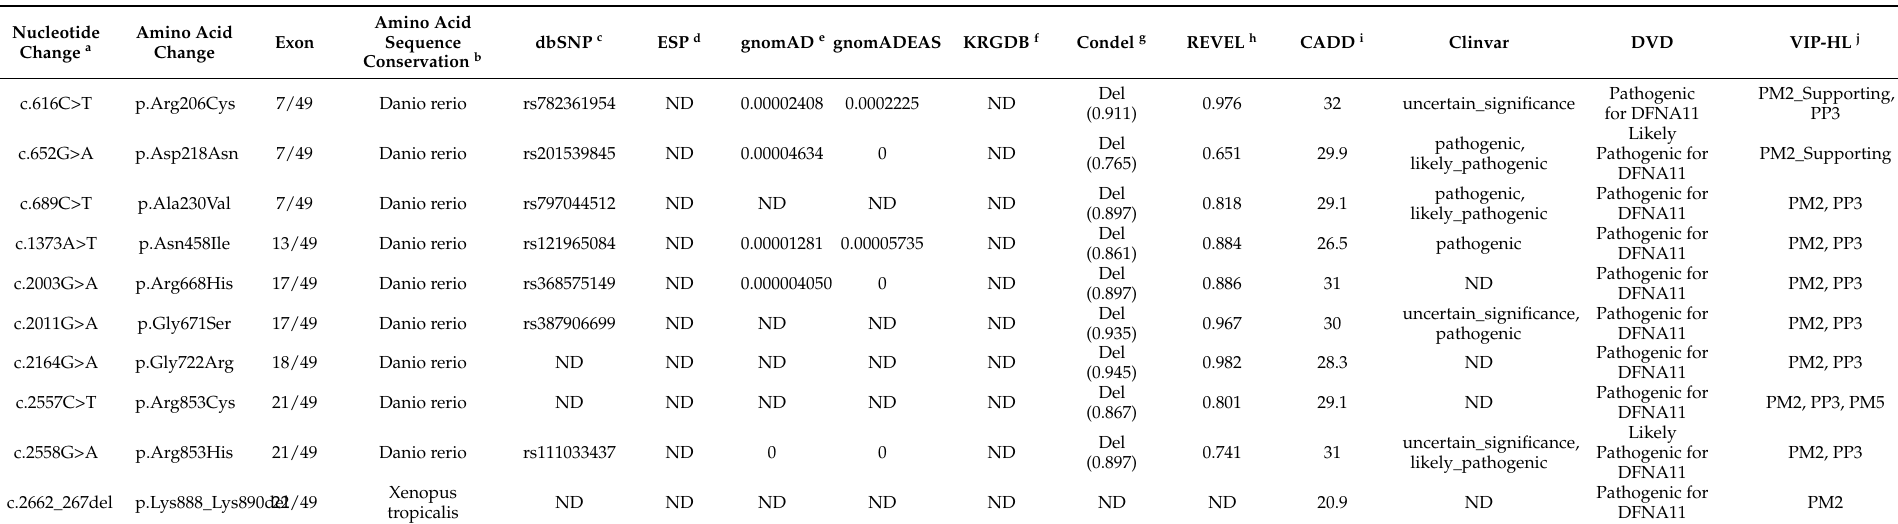
Table 4. Clinically reported DFNA11 affected families in the